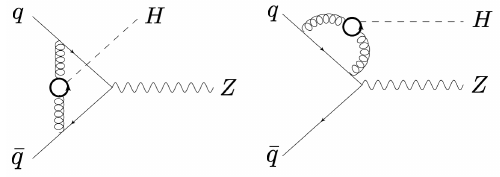
Figure 5: Sample diagrams of the two-loop class-I which are proportional to λ thick solid lines denote the massive top